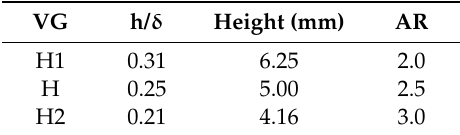
Table 4. Vortex generator dimensions and aspect ratios (AR).